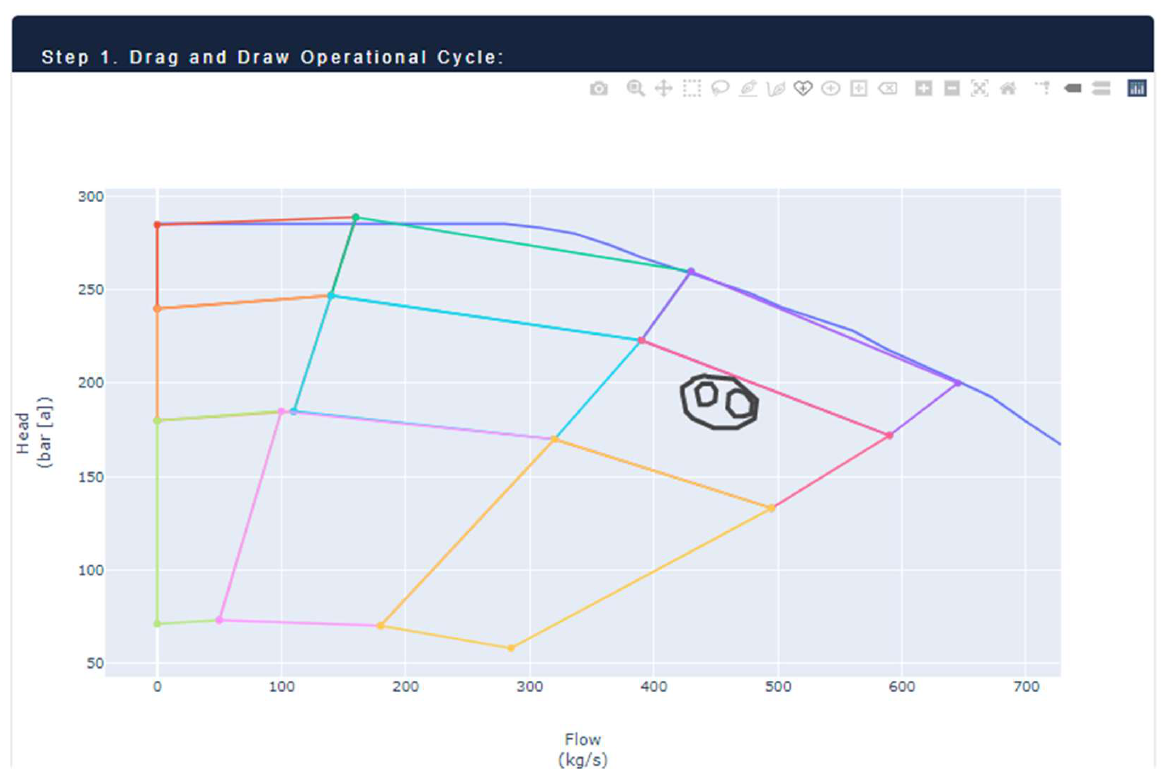
Figure 11. The user interface used to drive operational consequence decision support tool: Operator ‘draws’ (black line) anticipated trajectory across pump curve representation.